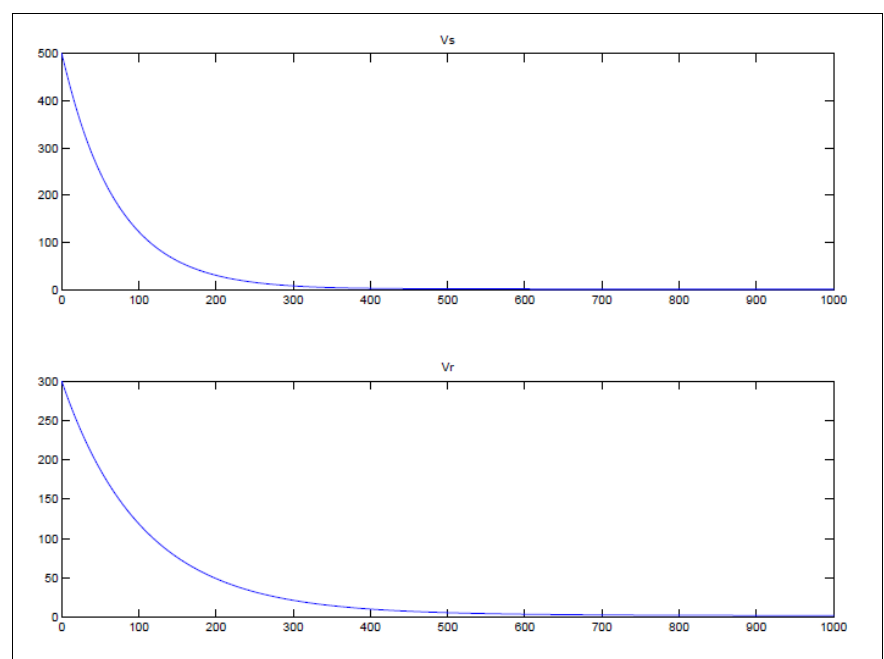
Figure 4. Sensitive and resistant viruses dynamics (concave